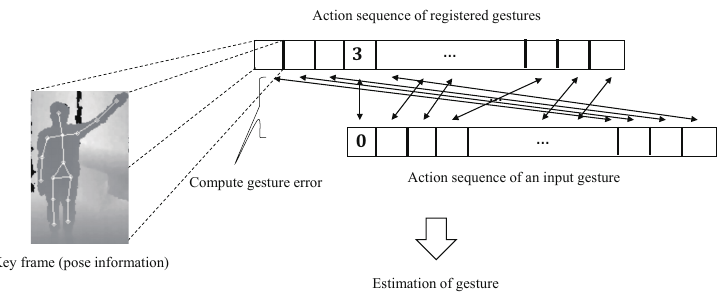
Figure 7. Action sequence matching.